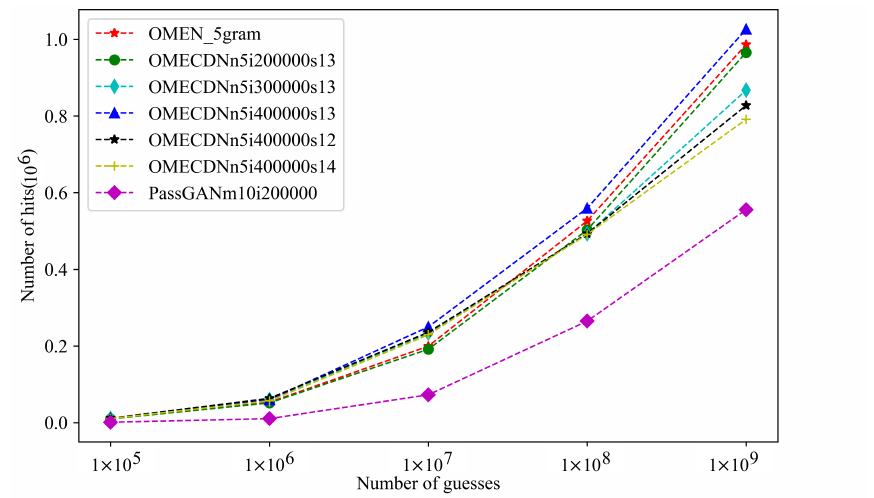
Figure 6. The hit rate amounts for the three models.